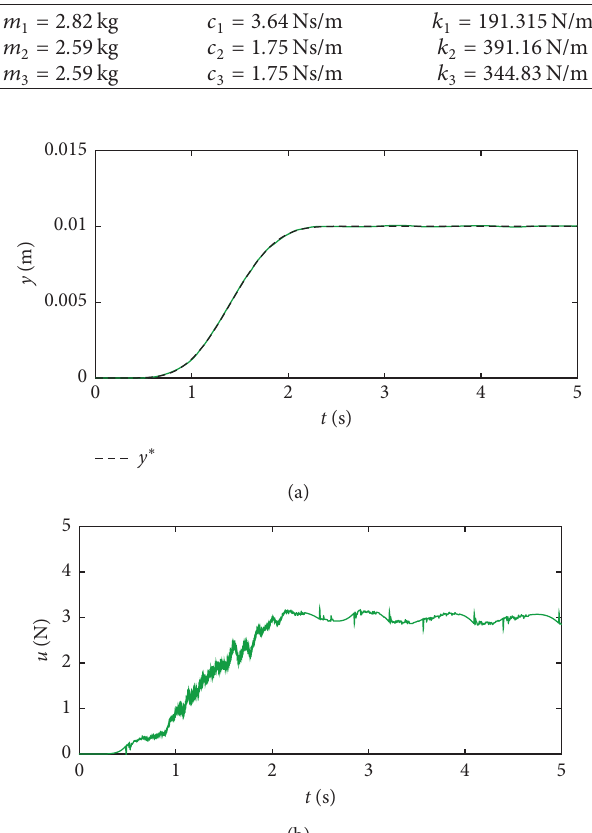
Table 1: Parameters of a 3 DOF mass-spring-damper system.